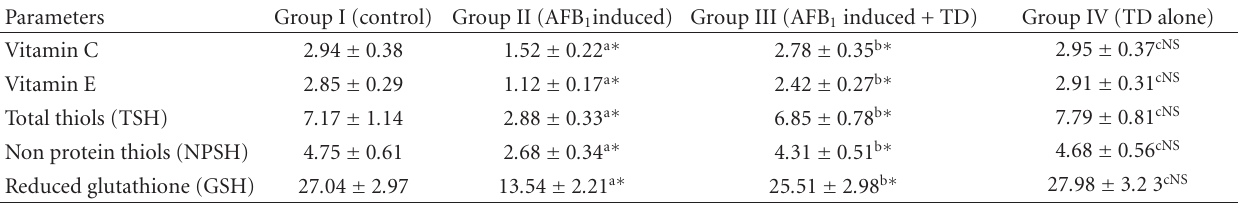
Table 5: E ff ect of TD on nonenzymic antioxidants and thiols in kidney of control and experimental animals.